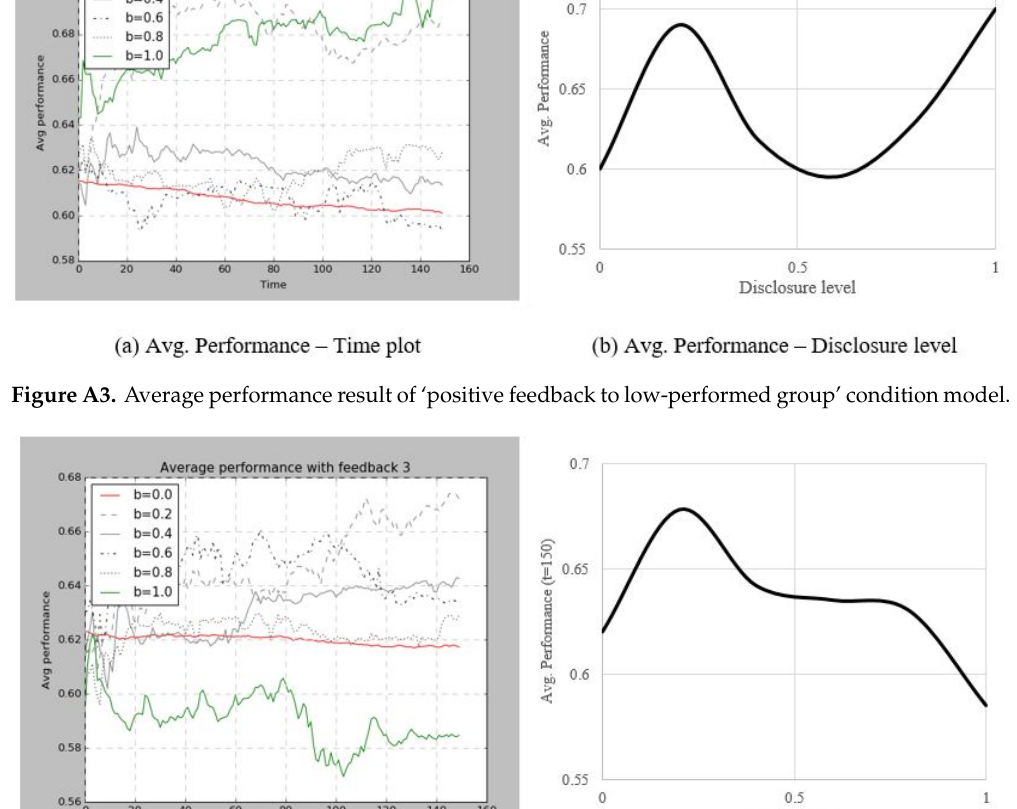
Figure A4. Average performance result of ‘negative feedback to low-performed group’ condition model .